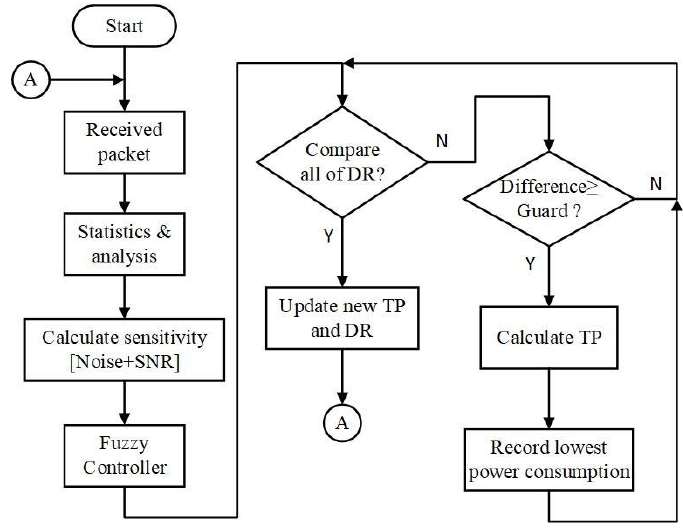
Figure 9. Flow chart for the control algorithm.